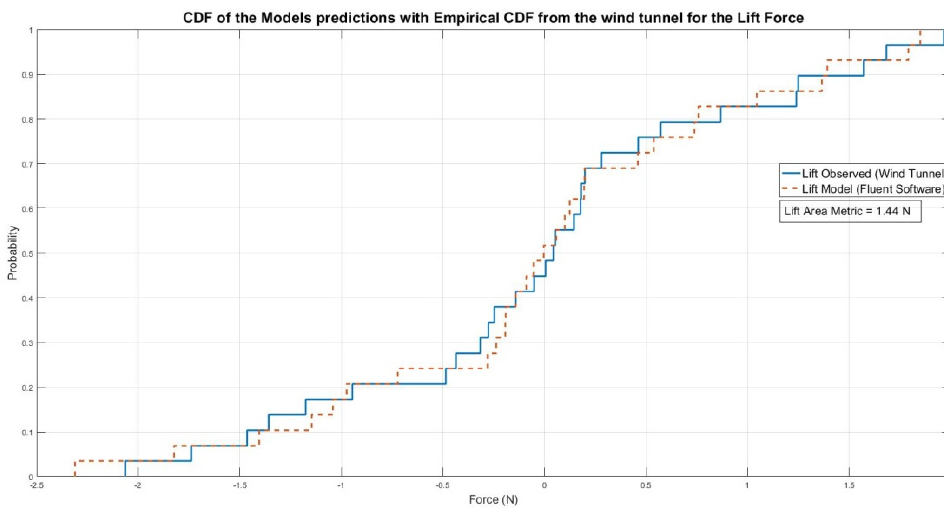
Figure 26. Area metric results for lift forces.